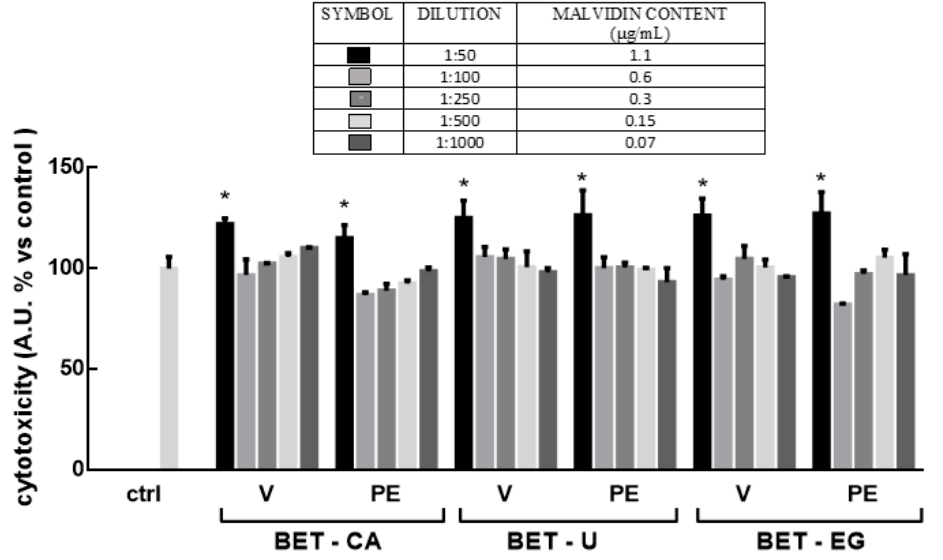
Figure 2. HaCat spheroids were treated with pomace extracts (PE) in NaDES formulations (range in content of malvidin: 0.05–1.1 µ g mL − 1 ) for 24 h: betaine—citric acid (BET-CA), betaine—urea (BET-U) and betaine—ethylen glycol (BET-EG). Corresponding dilutions of the NaDES mixtures used for extraction, without grape pomace extracts, were utilized as the control (vehicle (V)). LDH activity was spectrophotometrically quantified in a cellular medium as an index of cytotoxicity, as described